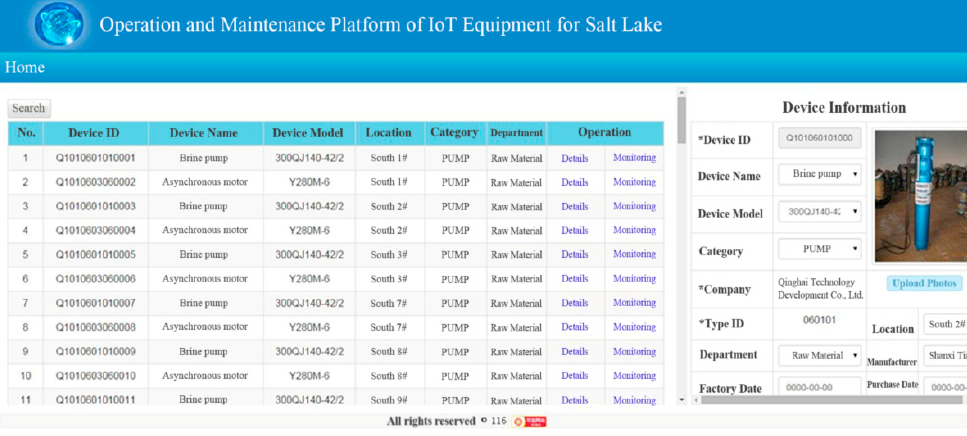
Figure 9. Device static information list.